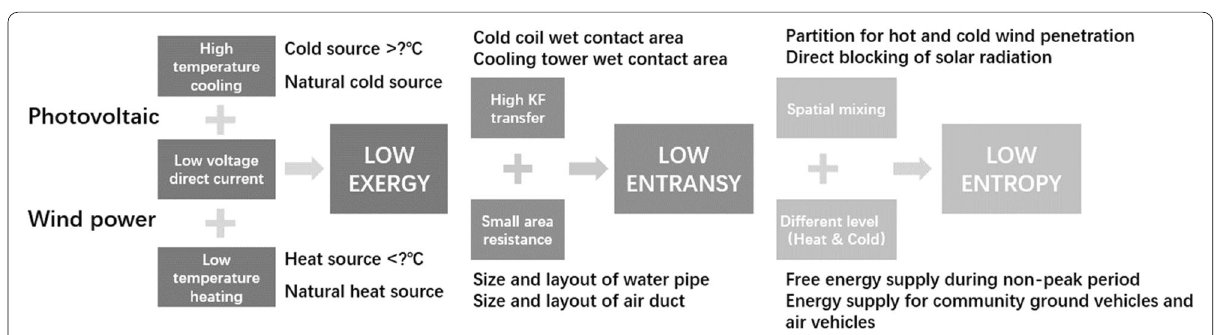
Fig. 14 Field operation to achieve low exergy, low dissipation, and low entropy